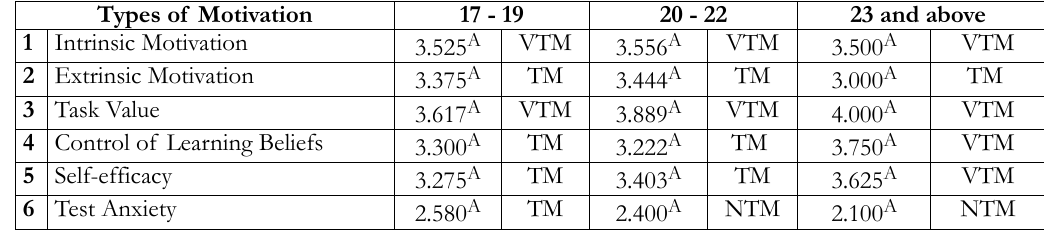
Table 2. The Respondents’ Motivation in Science Learning when Grouped by Age 1